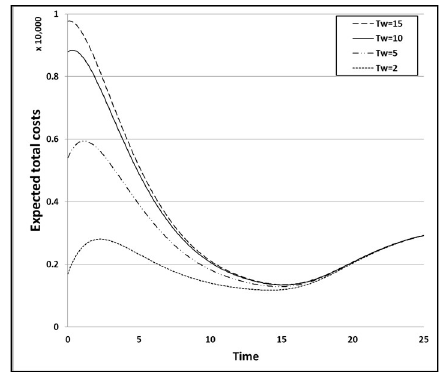
Figure 12. Expected total cost subject to the warranty period for the 1 st condition.